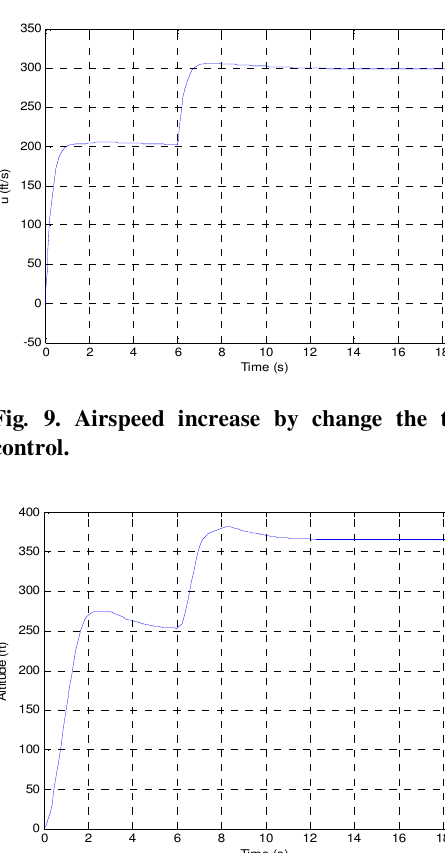
Fig. 10. Altitude change when throttle change.